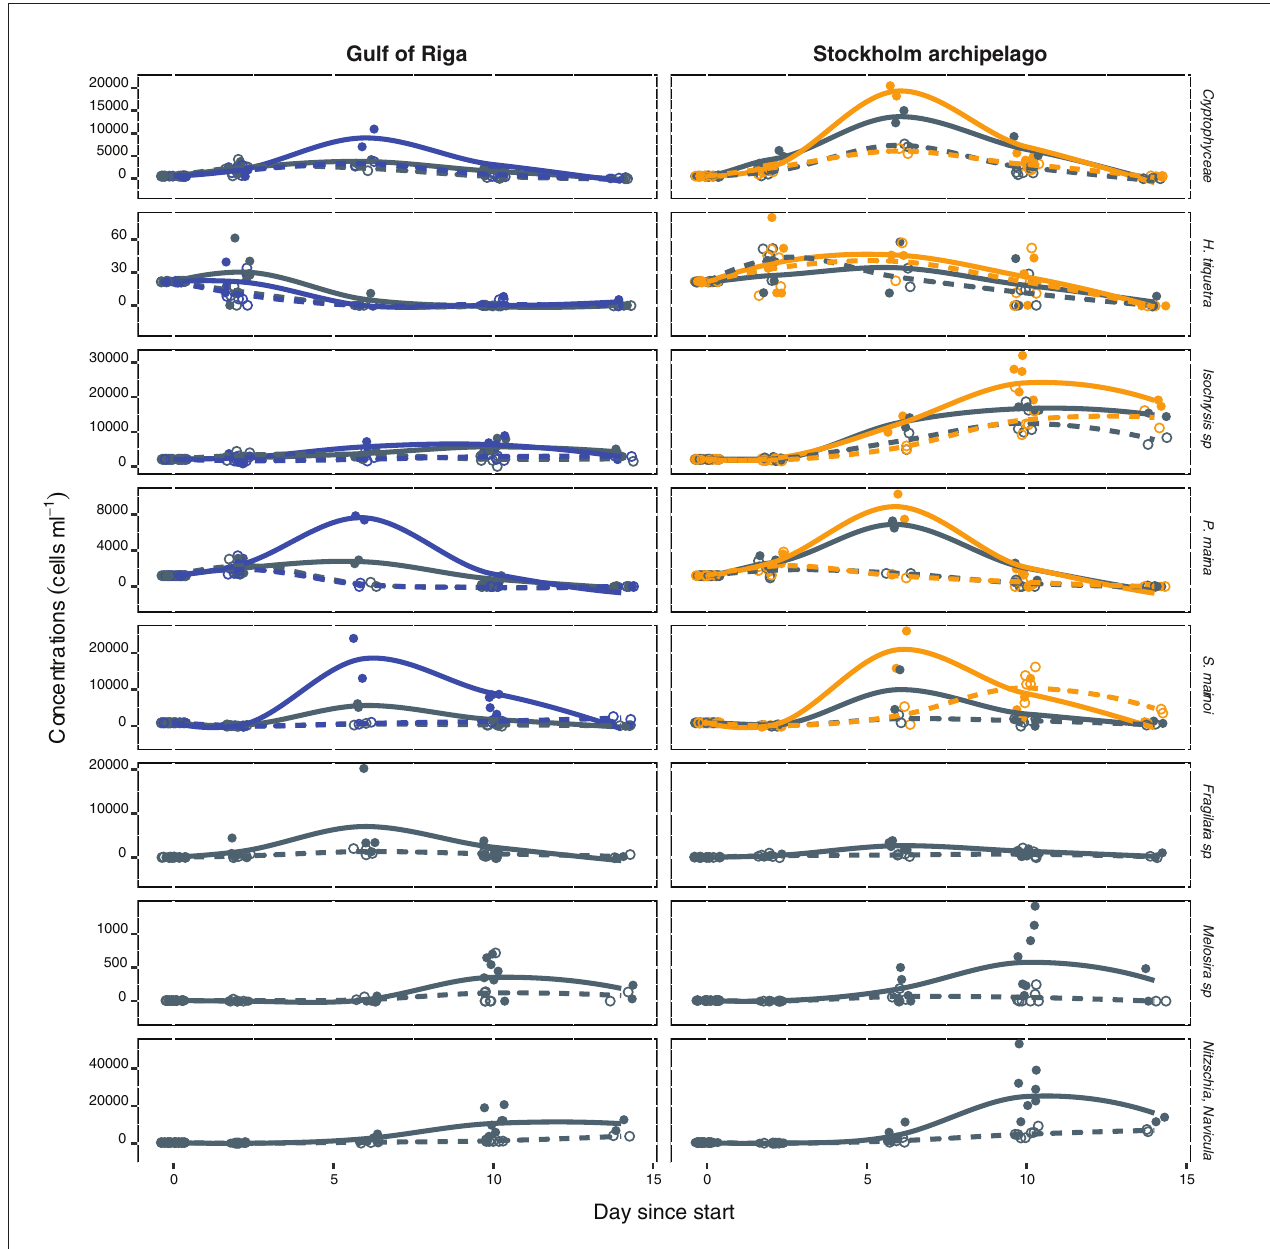
FIGURE 5 | Concentrations in cells ml − 1 of the different algae species over time (days) in the common gardening experiment, for the treatments: algae community, nutrient level, and zooplankton population, figure head shows the E. affinis populations. Color, line-type, and point shape codes are: blue and orange are respective GOR and STHLM population in the pelagic algae treatment, gray is the pelagic + benthic diatom treatment (same for both populations), solid and dashed lines are respective high and low nutrient treatment, filled and open circles are respective high and low nutrient treatment. Lines are fitted by local regression by the R package ggplot2 (Wickham, 2009), points are observed